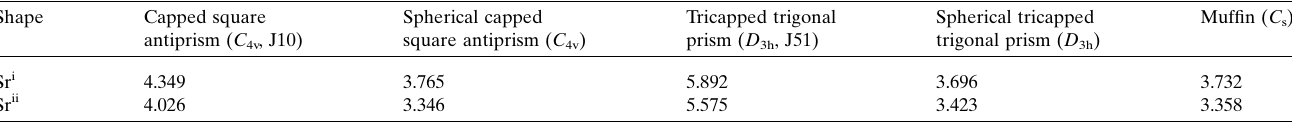
Table 2 Selected Continuous Shapes Measures (CShM) values for the geometry about the nine-coordinate Sr II ions of I . Shape